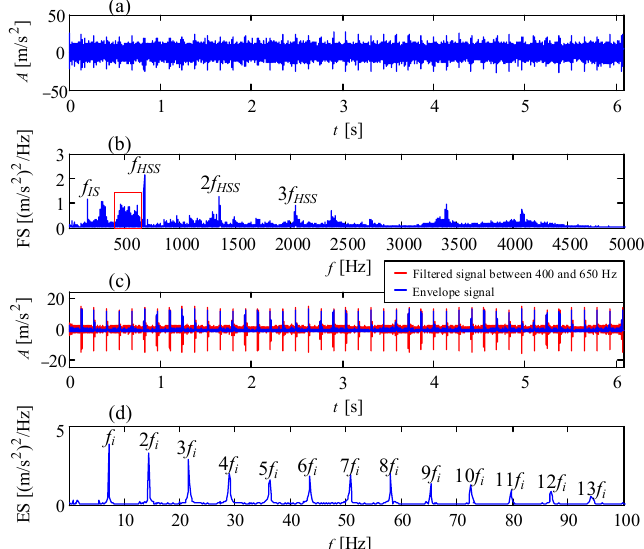
Figure 11. Vibration signal of the chipped pinion on intermediate shaft: ( a ) temporal signal; ( b ) Fourier spectrum; ( c ) filtered signal and envelope signal; ( d ) envelope spectrum.